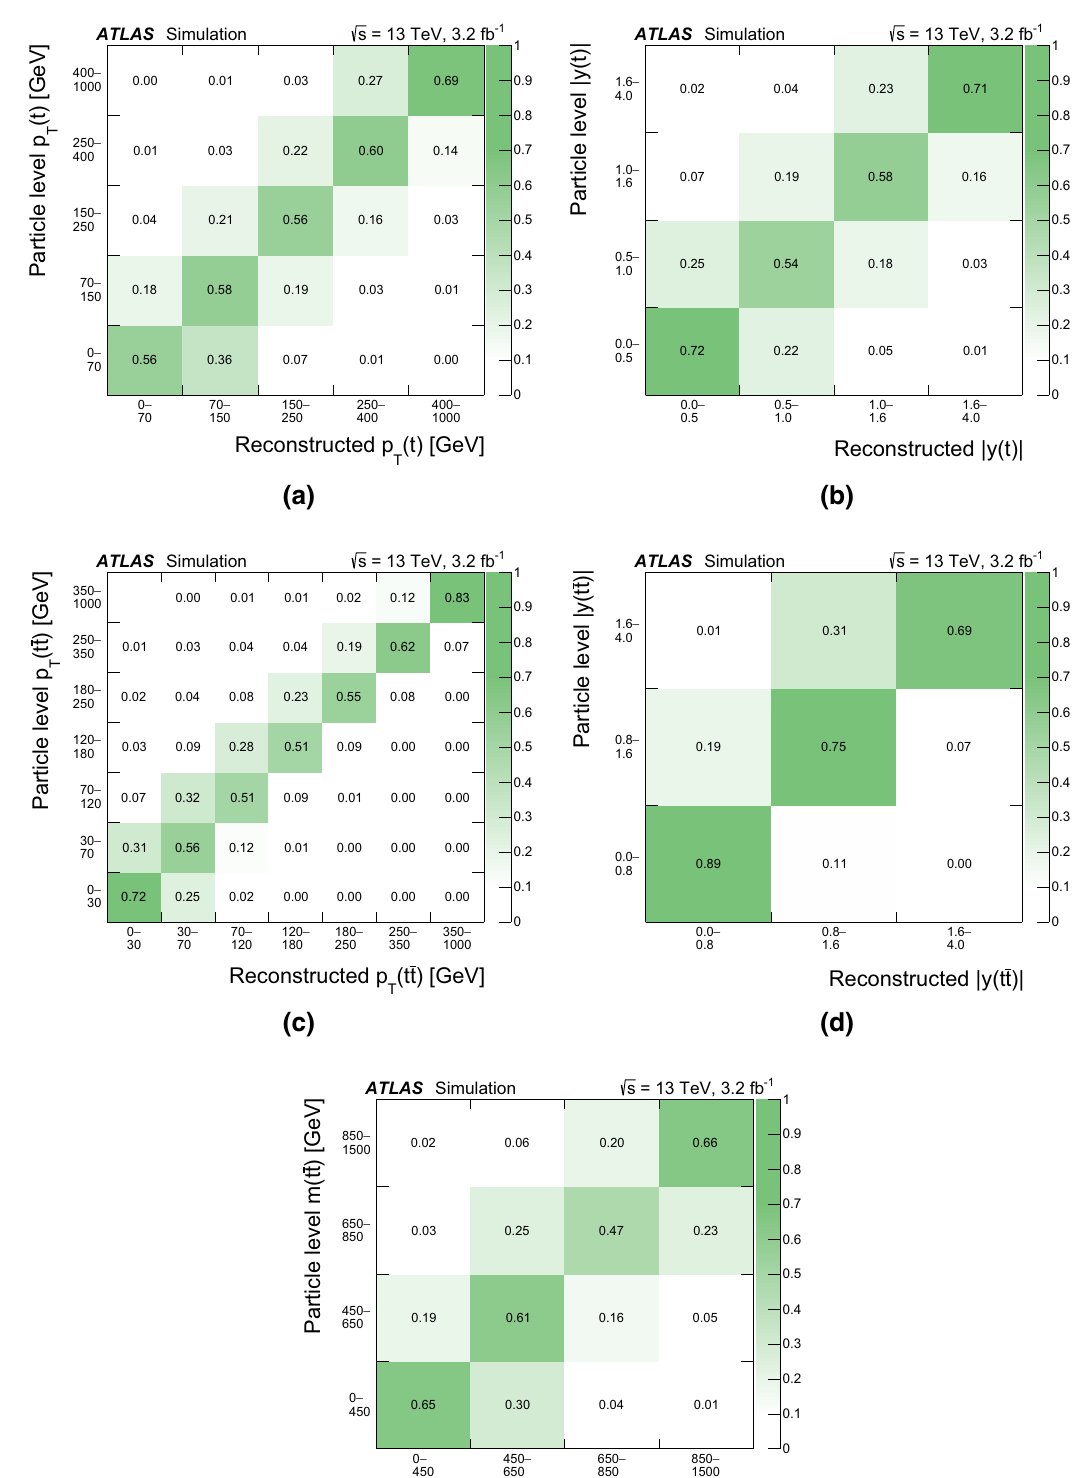
Fig. 3 The response matrices for the observables obtained from the nominal t ¯ t MC, normalised by row to unity. Each bin shows the proba- bilityforaparticle-leveleventinbin j tobeobservedinareconstruction-